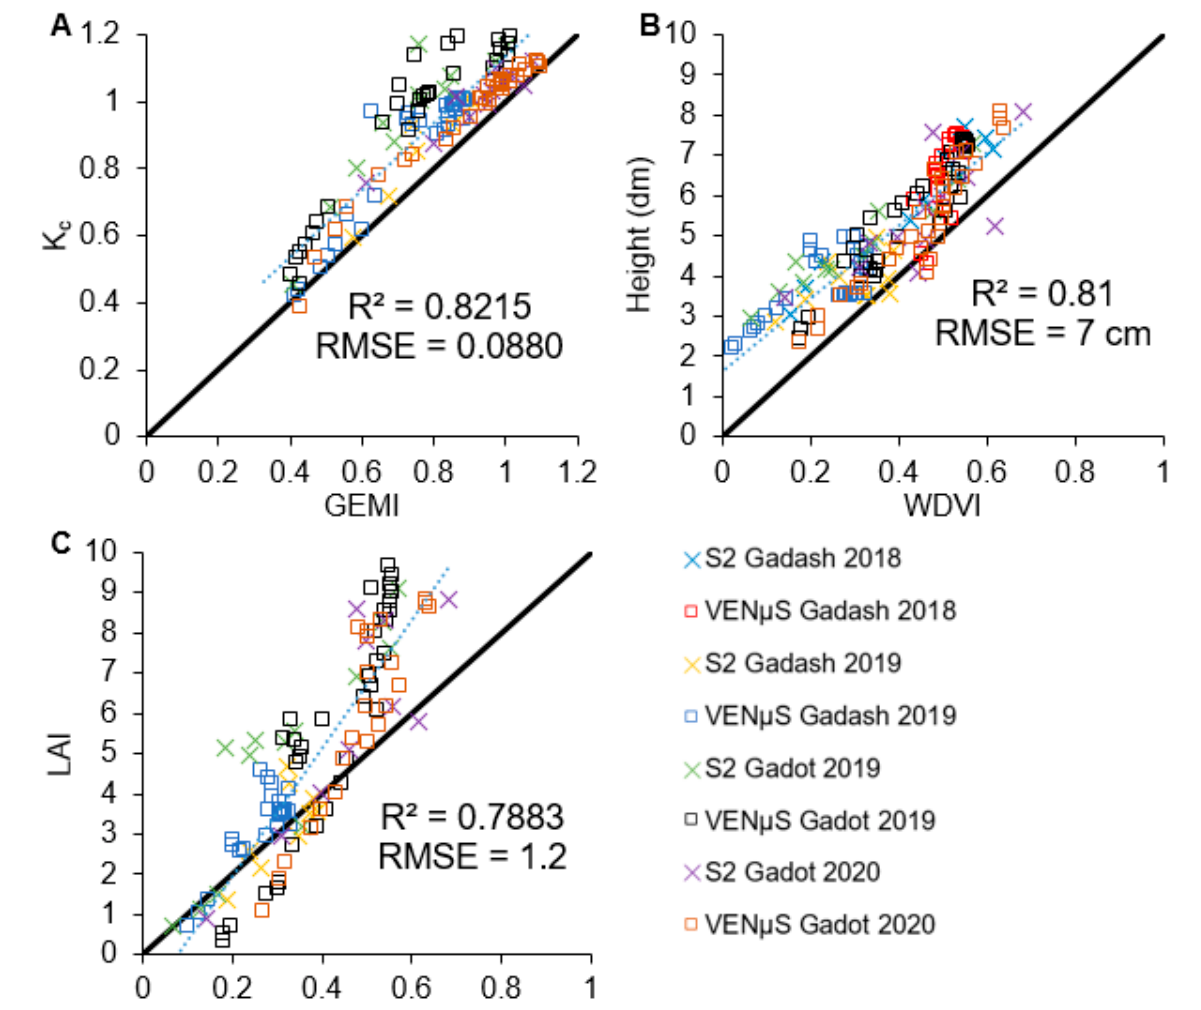
Figure 3. Vegetation Index linear regression models based on Sentinel-2 and VEN µ S imagery: ( A ) K c –GEMI Sentinel-2 and non-transformed VEN µ S images acquired during three processing tomato growing seasons; ( B ) Vegetation height (dm)–WDVI Vegetation Index regression model based on Sentinel-2 and transformed VEN µ S images acquired during four processing tomato growing seasons; ( C ) Vegetation LAI–WDVI Vegetation Index regression model based on Sentinel-2 and transformed VEN µ S images acquired during three processing tomato growing seasons. Table 5. Performance statistics of newly developed Sentinel-2-based LAI, Height, K c models for the best performing VIs, and the SNAP biophysical processor LAI estimation algorithm's performance. Performance statistics of additional VIs can be found in Appendix B.